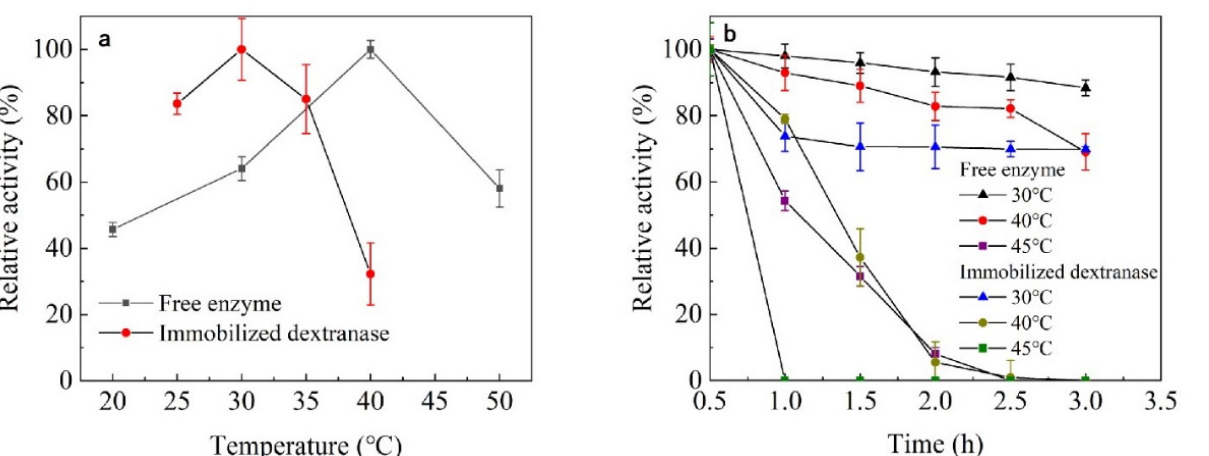
6 of 14 Figure 2. E ff ect of di ff erent conditions on enzyme immobilization: ( a ) TiO 2 content, ( b ) temperature, ( c ) time and ( d ) pH. On the bar chart, the di ff erent lowercase le tt ers show that there are signi fi cant di ff erence ( p > 0.05). The increased amount of enzyme could improve the e ffi ciency of enzyme fi xation; however, it seemed that excessive enzyme might lead to aggregation, and reduce the e ffi - ciency of enzyme fi xation products. The result was similar to the report of Wanich Suksa-